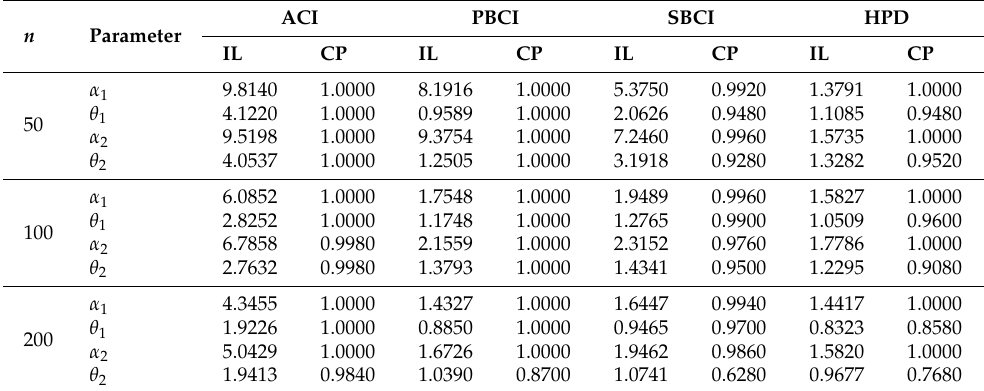
Table 6. Interval estimates of ( α t , θ t ) , t = 1,2 under Scheme